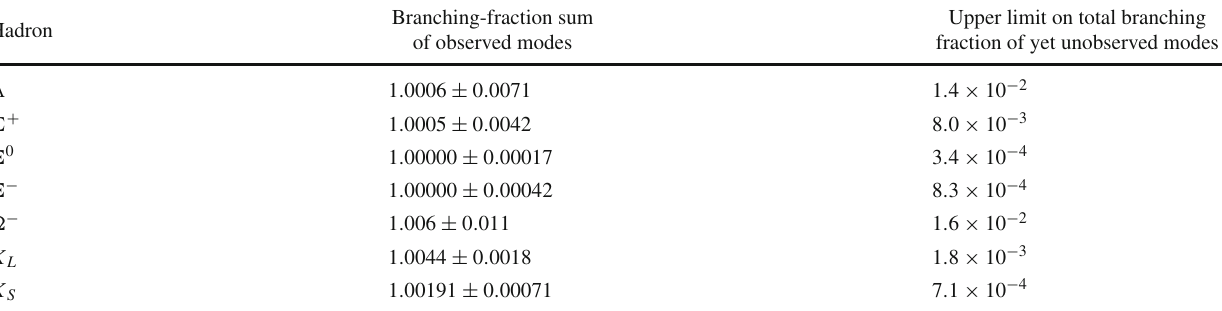
Table 1 The second column exhibits the sums of branching fractions of all the observed decays [43] of the (cid:8) , (cid:10) + , (cid:20) 0 , (cid:20) − , and (cid:21) − hyperons andofthe K L and K S mesons.Thelastcolumncontainstheupperlimits